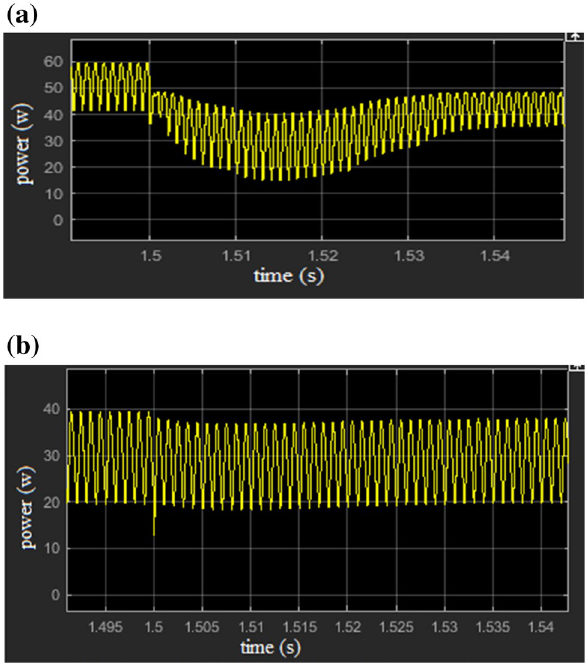
Fig. 10 a Power signal at t = 1.5 s (Conventional MPPT). b Power signal at t = 1.5 s (thermography